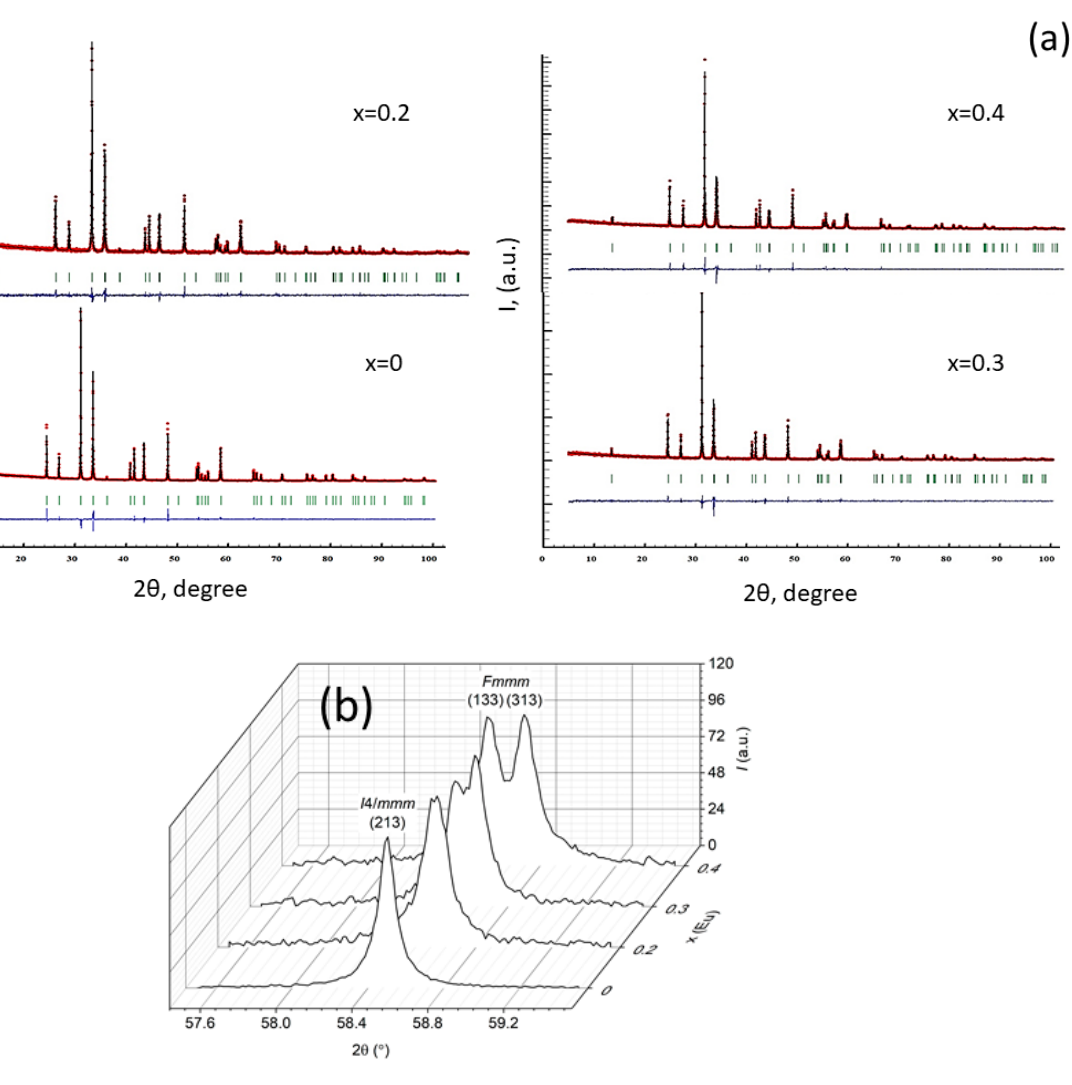
Figure 7. Diffraction patterns for La 1.81 − x Eu x Sr 0.19 CuO 4 (x = 0 ÷ 0.4) crystals ( a ) and splitting for diffraction peaks at 58.5 ◦ with increase in Eu content in La 1.81 − x Sr 0.19 Eu x CuO 4 (x = 0 ÷ 0.4) single crystals ( b ).